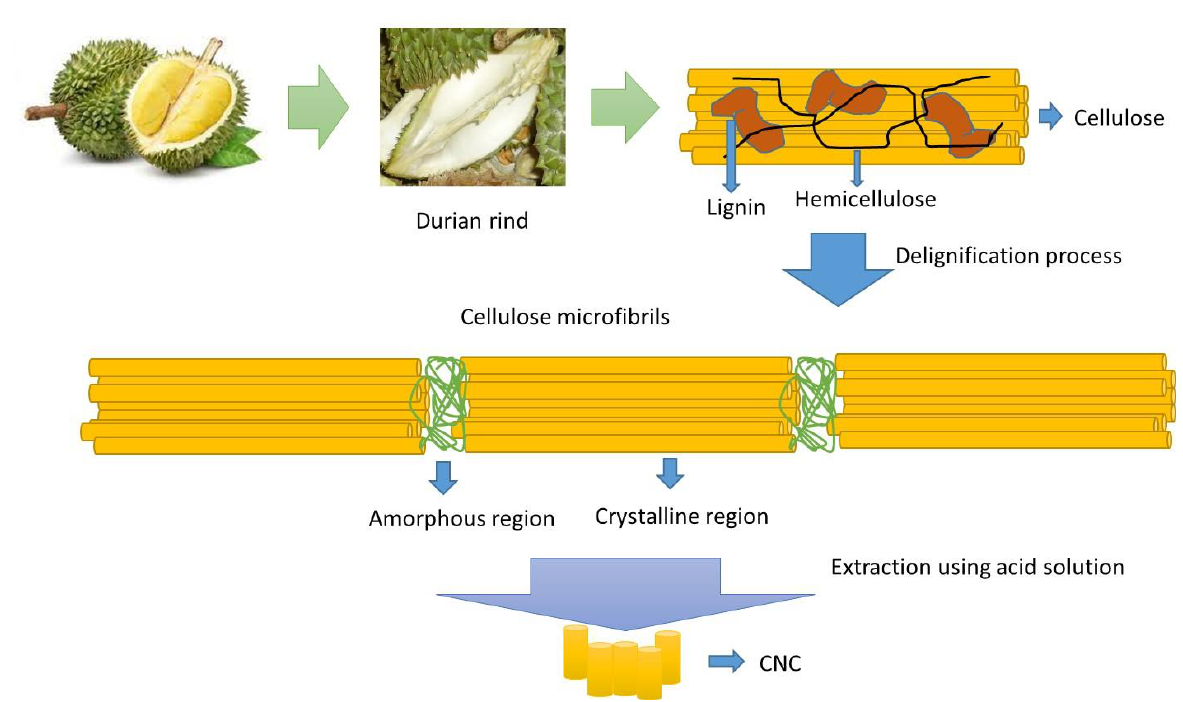
Figure 1. Schematic representation of the delignification and extraction processes of durian rind into CNCs.